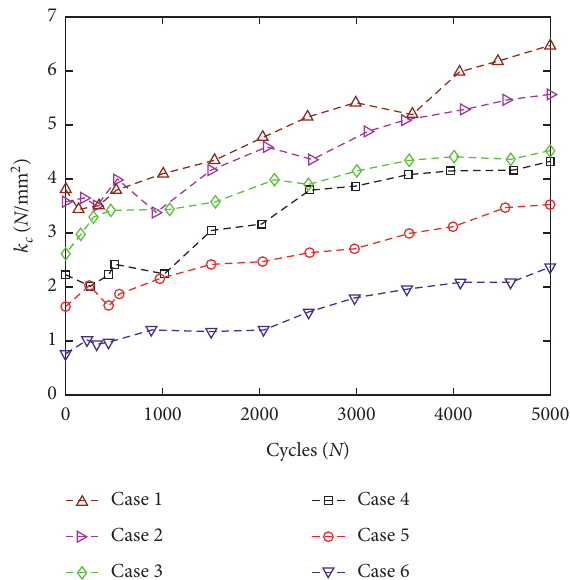
Figure 11: Variation in cyclic stiffness of mono-pile with